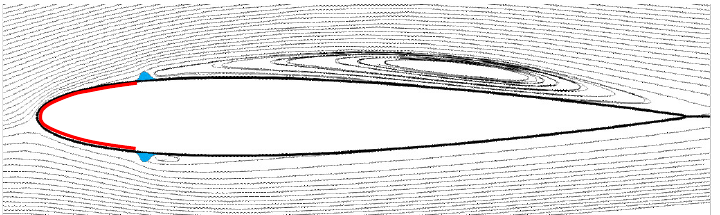
Figure 10. Streamlines for x hs = 16 and x hp = 16 cases. Bold lines show the airfoil and light blue area represents the ice. The red line represents the heater